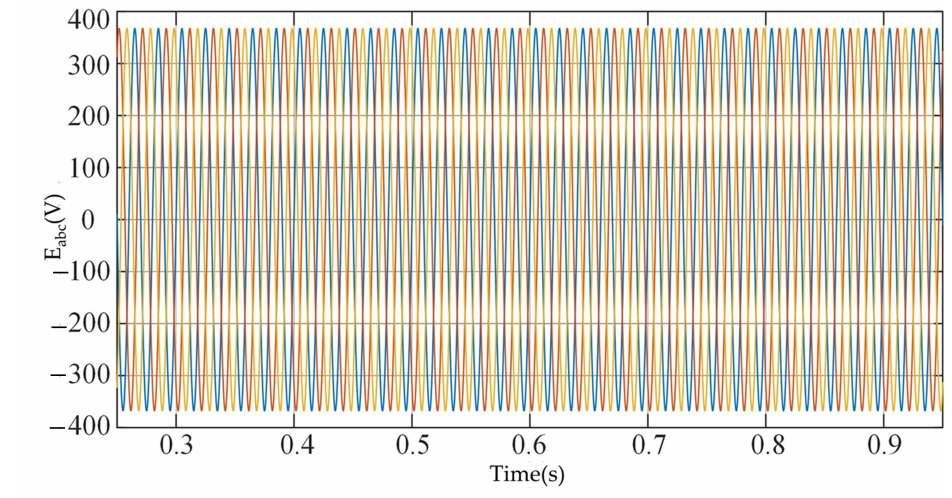
Figure 19. Grid voltage variation during the transition